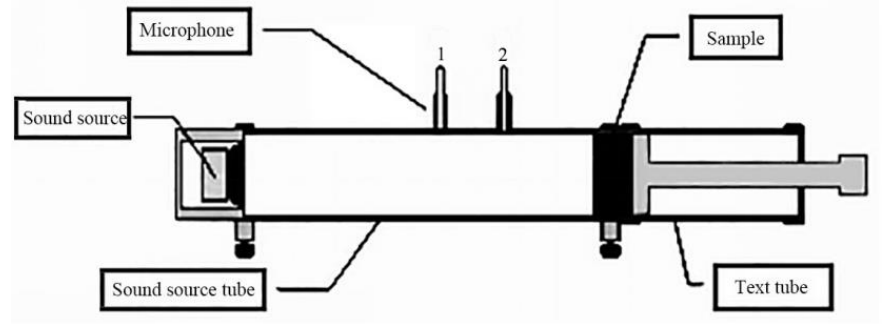
Figure 1. Schematic diagram of the sound-absorption test.